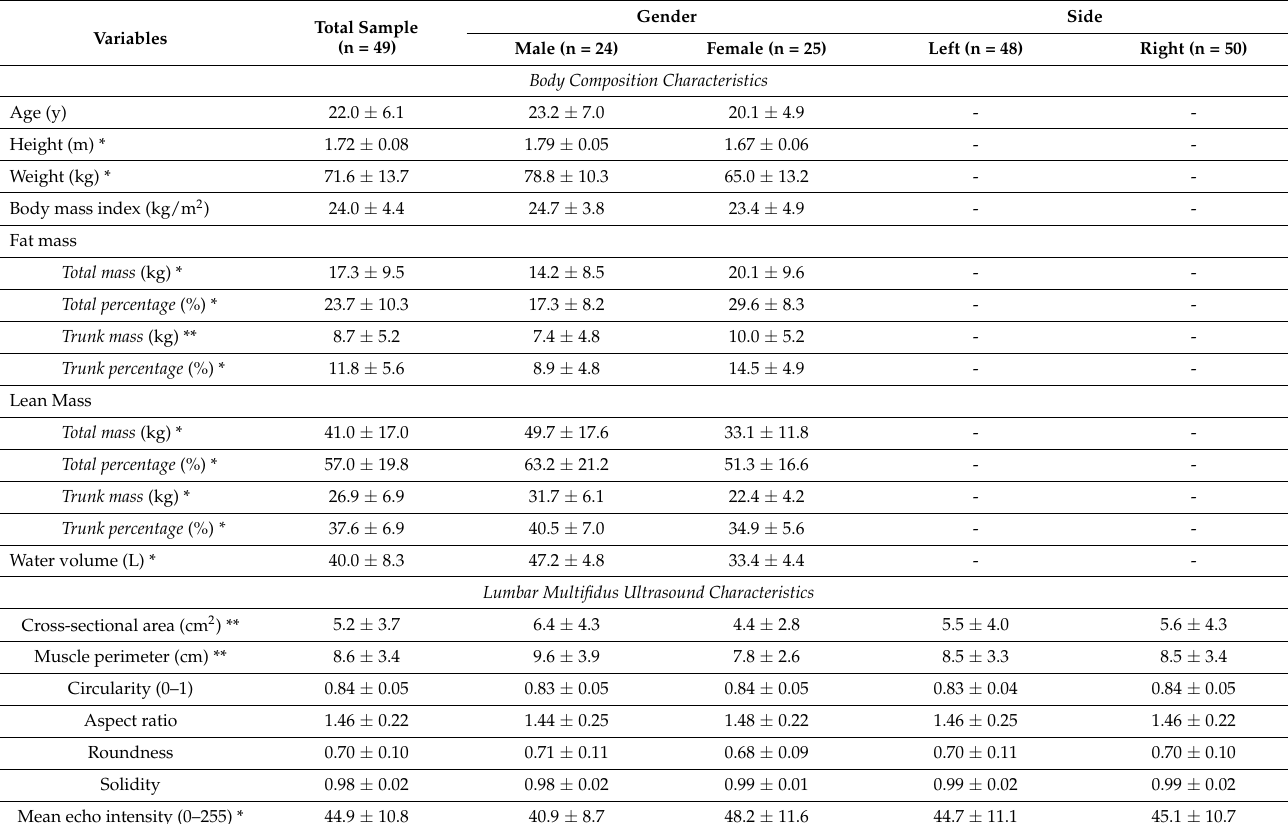
Table 1. Participants’ sociodemographic and US